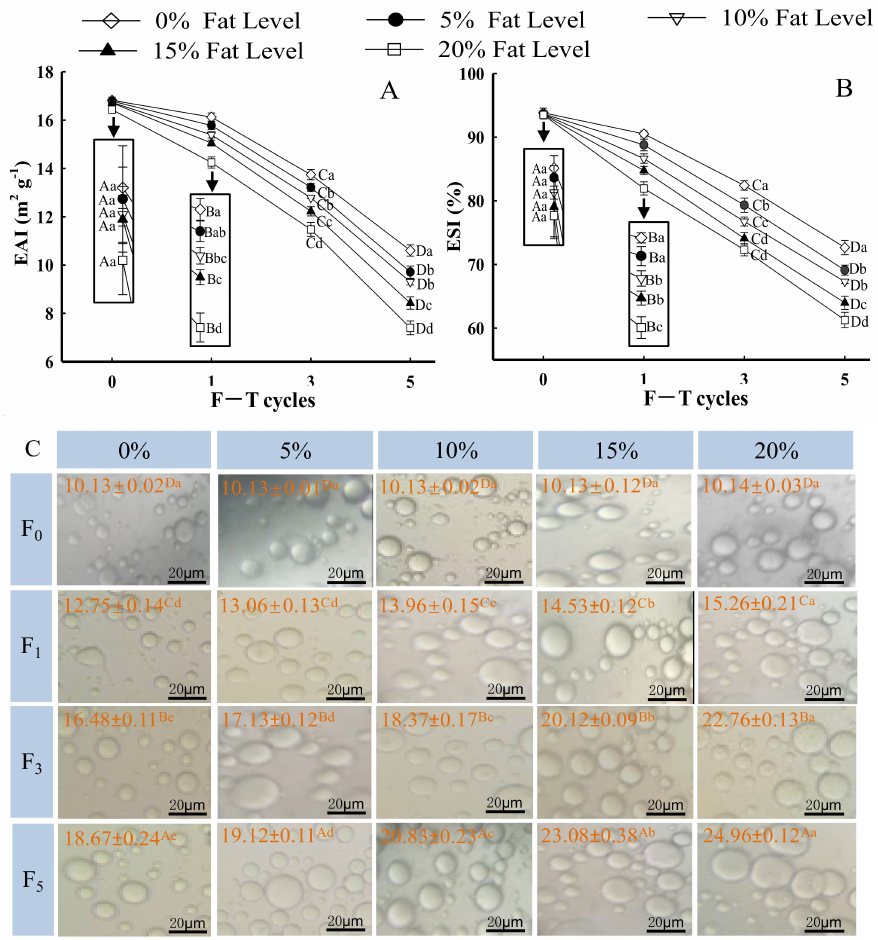
Figure 4. Influence of F–T cycles on emulsifying activity index (EAI) ( A ), emulsifying stability index (ESI) ( B ), the diameter of myofibrillar protein emulsion droplets ( µ m) and the distribution ( C ) of myofibrillar protein from quick-frozen patties with different fat levels. The magnification was set as × 40. Values are given as the mean ± SE. The means for the same fat levels. with different uppercase letters (A to D) and the same F–T cycles with different lowercase letters (a to e) differ significantly ( p <